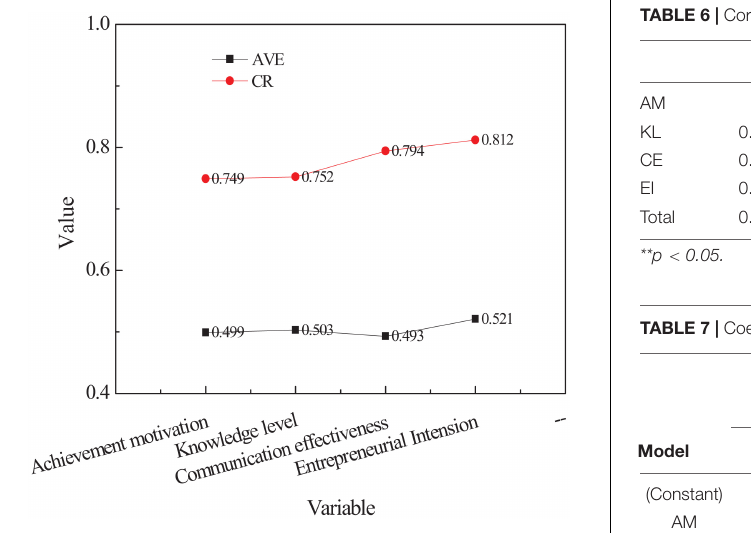
FIGURE 2 | Comparison of AVE and CR mean-variance of Variables.